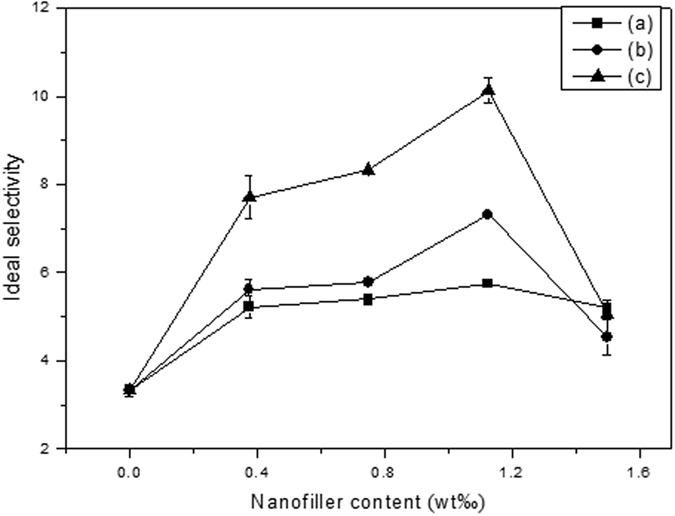
Effect of graphene nanosheets content in the EC polymer matrix on the C3H6/C3H8 ideal selectivity: (a) L-rGO MMMs; (b) rGO MMMs; (c) nanoporous rGO MMMs. (Feed pressure at 0.1 MPa, temperature at 298 K).